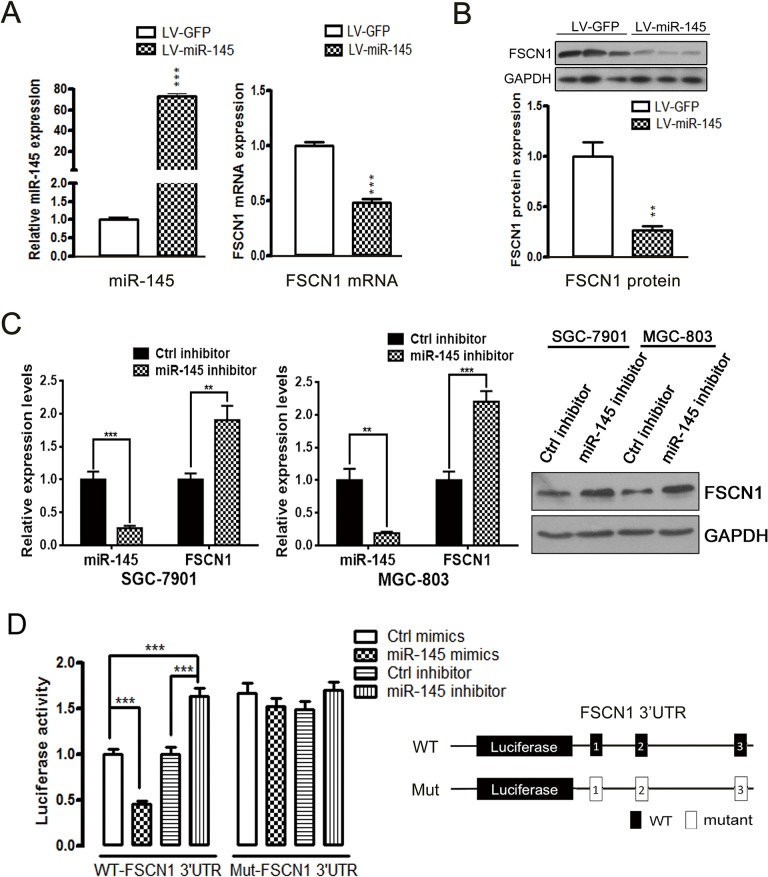
miR-145 suppresses FSCN1 expression by directly targeting the 3’ UTR of FSCN1.(A) qPCR data of FSCN1 mRNA levels in MGC-803 cells stably expressing the LV-GFP (control) and LV-miR-145 lentiviral vectors (right), and qPCR results showing miR-145 overexpression levels (left). (B) miR-145 overexpression significantly down-regulated the expression of the FSCN1 protein in MGC-803 cells. (C) qPCR data of miR-145 levels and FSCN1 mRNA levels in SGC-7901 (left) or MGC-803 (middle) cells transfected with Ctrl inhibitor or miR-145 inhibitor. The miR-145 inhibitor significantly up-regulated the expression of the FSCN1 protein in SGC-7901 and MGC-803 cells (right). (D) A luciferase reporter vector containing human WT-FSCN1 3’ UTR or Mut-FSCN1 3’ UTR was co-transfected with miR-145 mimics or miR-145 inhibitor into MGC-803 cells. Luciferase activity was measured at 48 h after transfection and normalized to β-gal activity. The data are presented as the mean±SD of three individual experiments (**P<0.01; ***P<0.001).